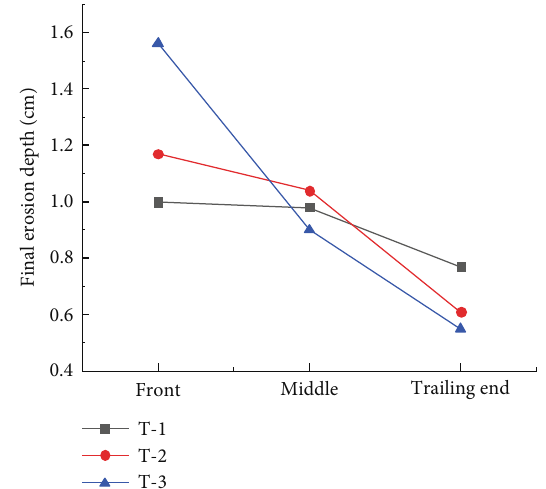
Figure 11: A comparison of erosion depths for three di ff erent red mud